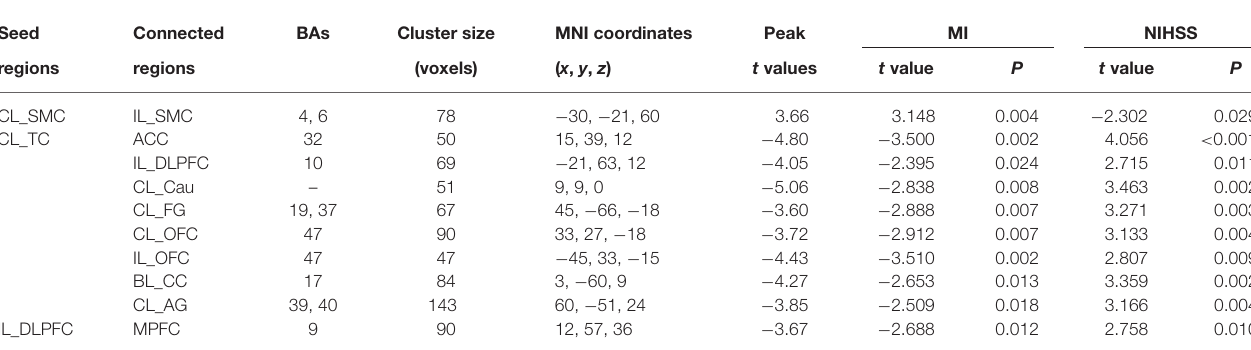
TABLE 3 | Linear FCS changes after stroke ( P < 0.05, corrected) and correlations between FCS strengths and clinical measures . Seed Connected BAs Cluster size MNI coordinates Peak MI NIHSS regions regions (voxels) CL_SMC